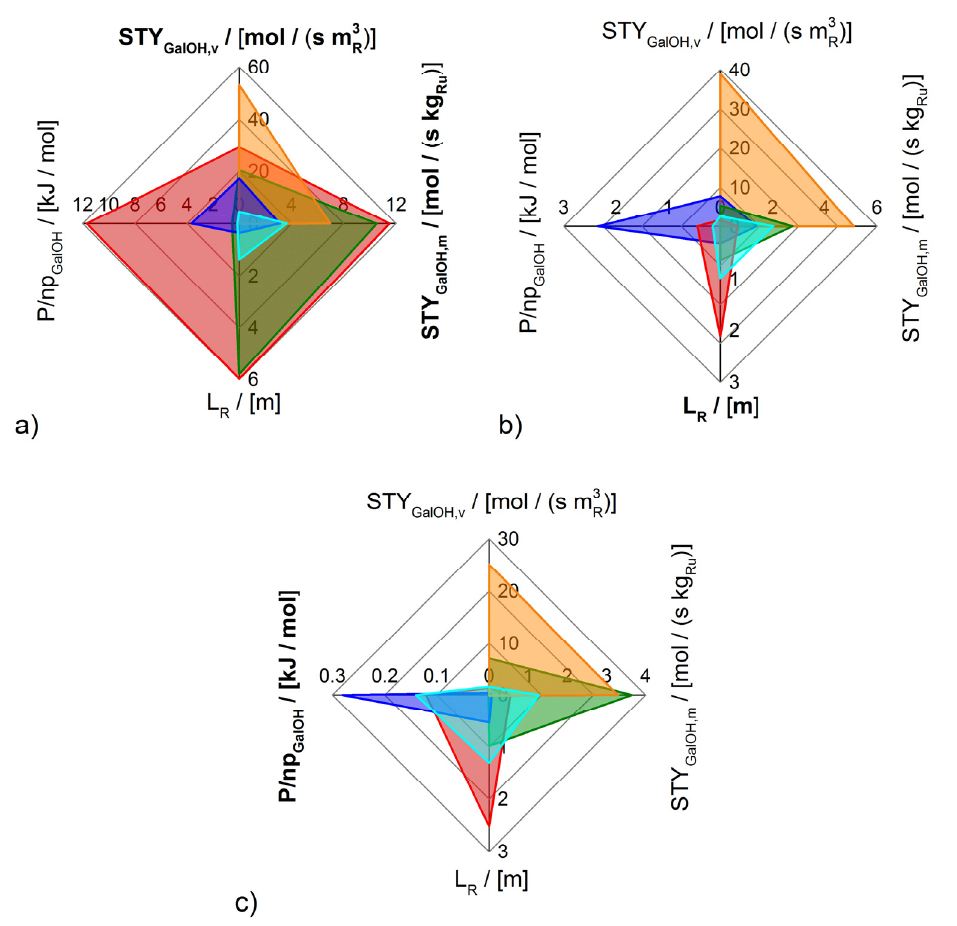
Figure 25. Performance parameters of the studied minichannel reactors: minichannel wall reactor, minichannel reactor packed with particles, minichannel reactor with foam packing, and trickle-bed reactors: conventional and miniaturised at flow conditions creating ( a ) maximal space-time yields, ( b ) minimal reactor lengths, and ( c ) minimal specific energy consumptions in the adiabatic hydrogenation of arabinose/galactose mixtures ( 𝑝 (cid:3036)(cid:3041) = 6 MPa , 𝑇 (cid:3036)(cid:3041) = 115 °C ).